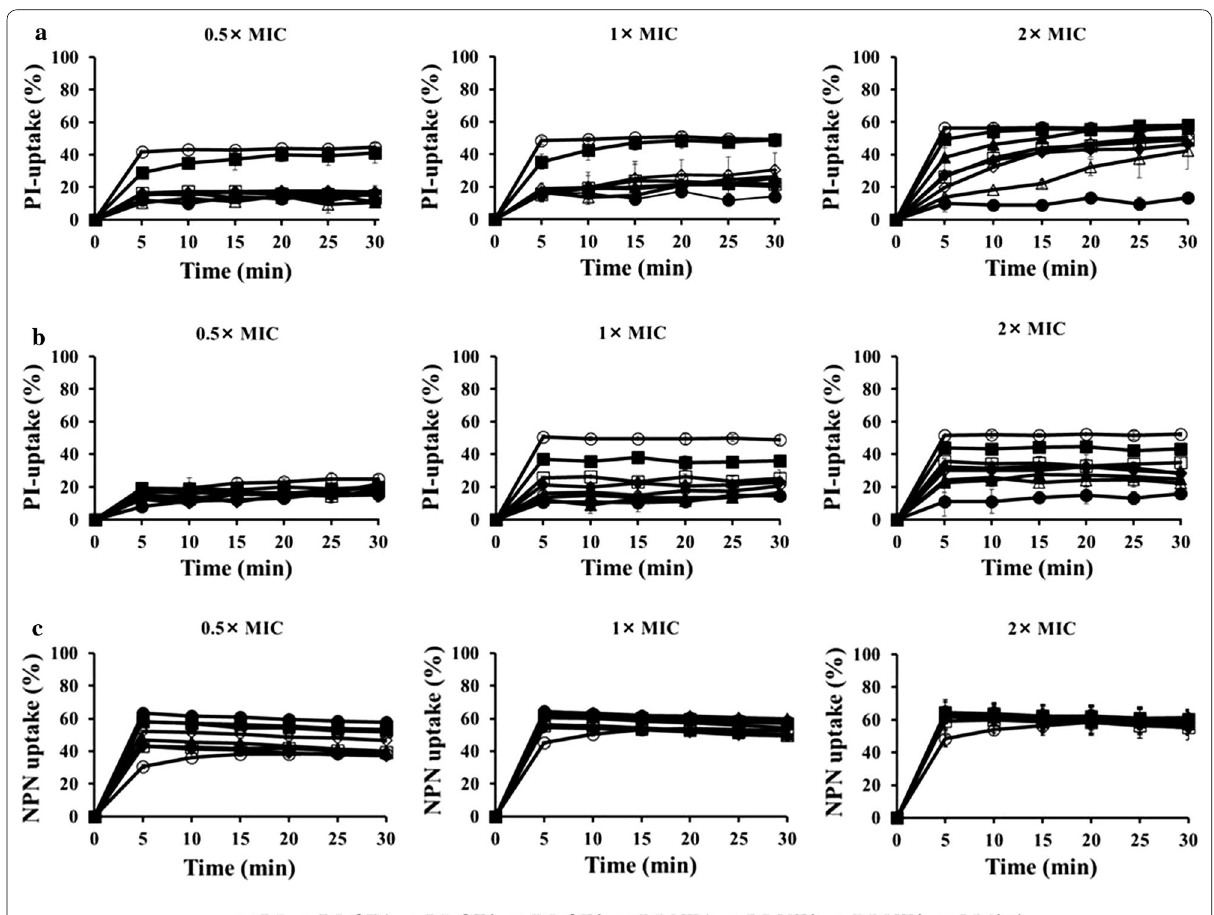
Fig. 5 Membrane disruption and permeabilization. Membrane disruption induced by peptides as detected by PI uptake at in a P. aeruginosa ATCC 27853 and b S. aureus ATCC 25923. c Outer membrane permeabilization induced by peptides as detected using NPN uptake at 0.5, 1, and 2 MIC in P. aeruginosa ATCC 27853. PI propidium iodide, MIC minimum inhibitory concentration, NPN n -phenyl-1-naphthylamine, × × × CT C-terminus, NT